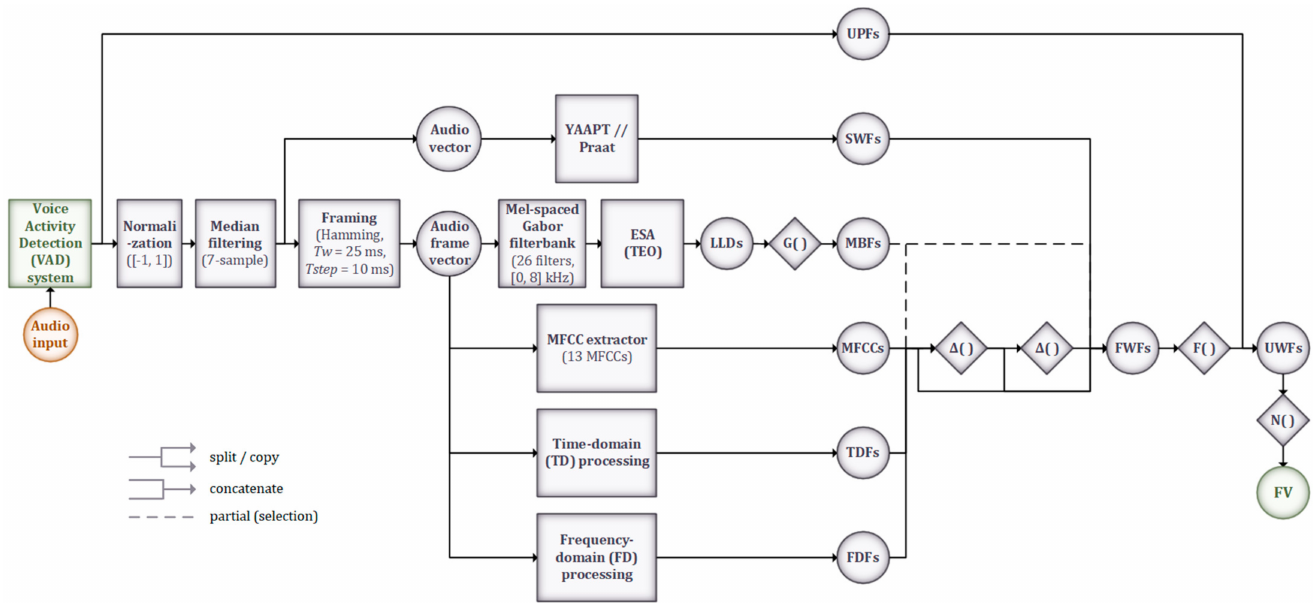
Figure 7. Detailed block diagram representation of the preprocessing and feature extraction stages of the DSD system. The VAD system is used to detect and split the input audio into utterances from each of which the set of 2260 features is